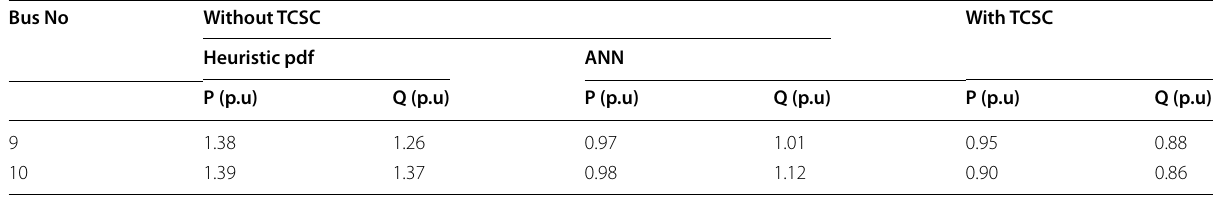
Table 18 Power flow comparison with and without presence of TCSC between the buses no. 9 and 10 for IEEE 57- bus system Bus No Without TCSC